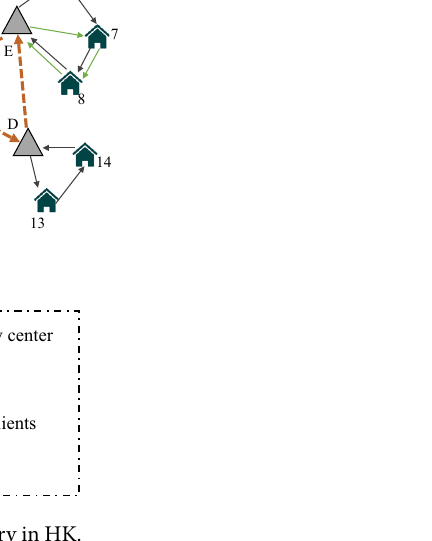
Figure 1. An example of two-echelon meal delivery in